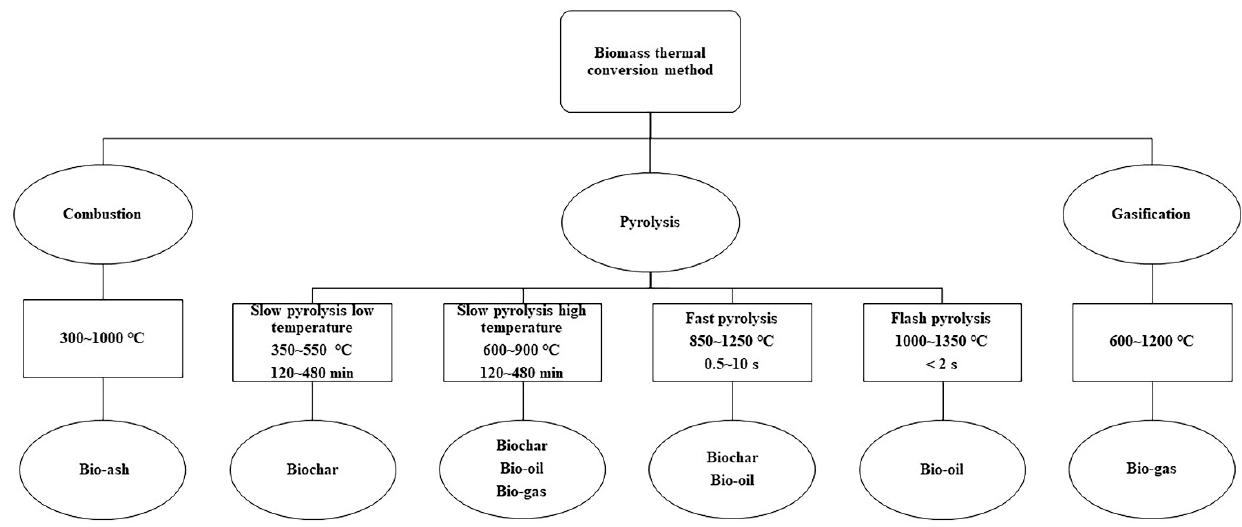
Figure 1. Thermochemical conversion modes of biomass fuels and their products [44,46].